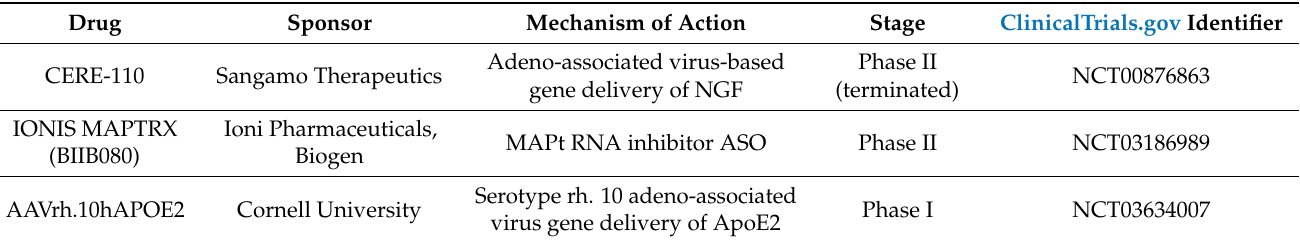
Table 13. Current gene therapies for AD